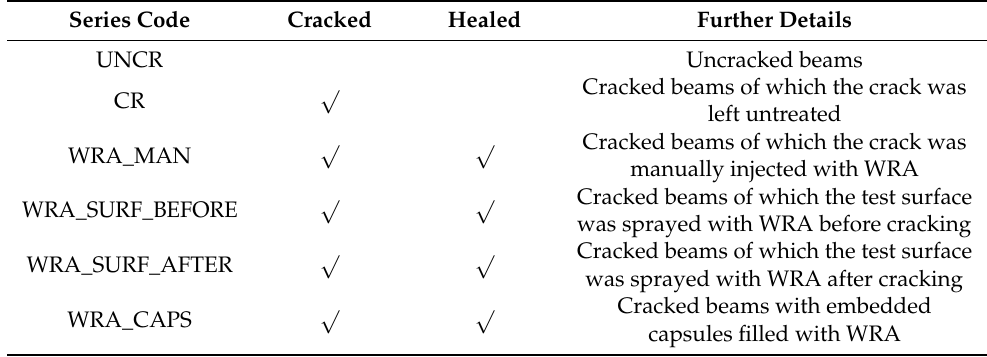
Table 3. Overview of test